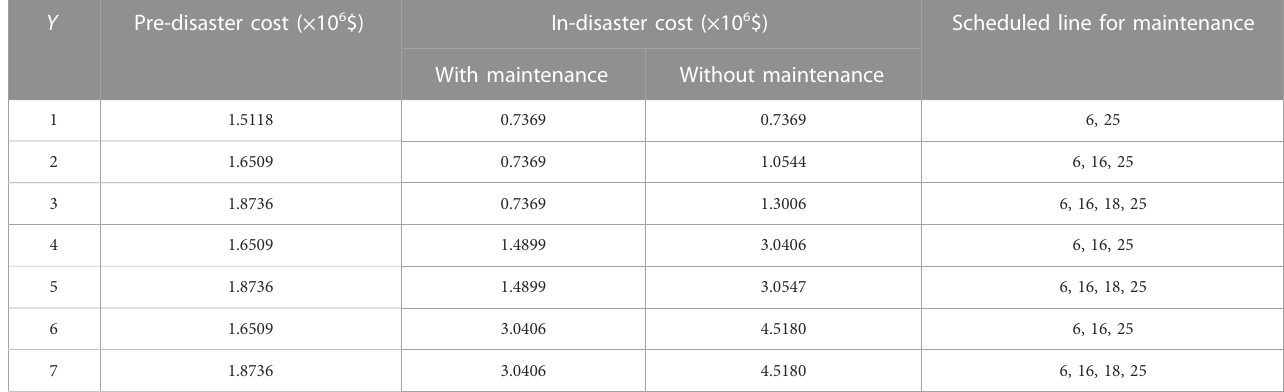
TABLE 3 The results under different attack budgets. Y Pre-disaster cost (×10 6